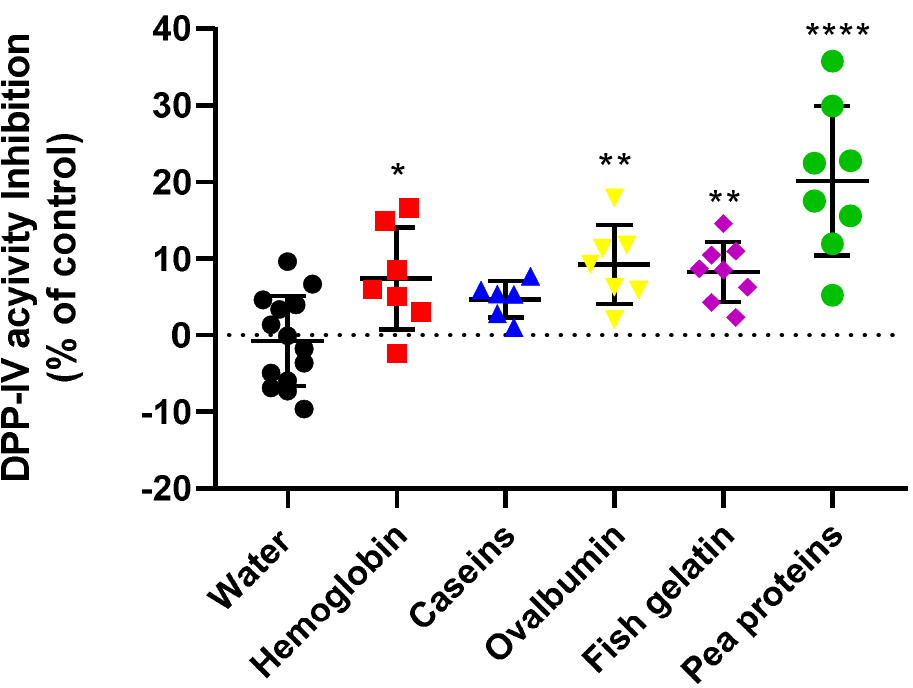
Figure 2. Dietary proteins decrease plasma DPP-IV activity after protein ingestion in rats. Overnight- fasted rats received either water (control) or a protein solution (hemoglobin, ovalbumin, caseins, pea proteins or fish gelatin) at a dose of 1 g · kg − 1 body weight by oral gavage 30 min before the collection of the blood samples. DPP-IV activity was evaluated by calculating the percentage of the DPP-IV activity inhibition of each protein relative to the control group (water). One–Way ANOVA analysis (Dunnett’s multiple comparison test) was performed to calculate statistical differences (* p <